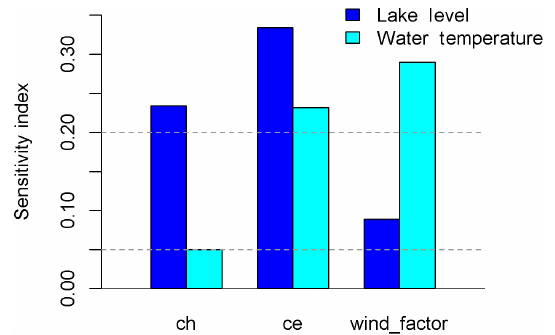
Figure 4. Sensitivity index (SI) after Lenhart et al. (2002) of GLM simulations of lake Baratz regarding the lake level (blue) and water temperature (cyan). The lower horizontal line (SI = 0 . 05) marks the threshold between small and medium sensitivity and the upper line (SI = 0 . 20) between medium and high